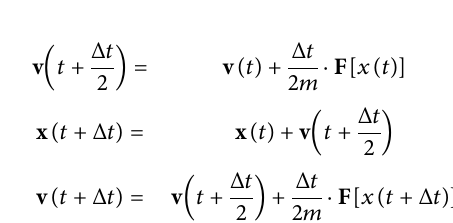
FIGURE 4 | Data fl ow and online learning implementations. Different colors of boxes in the data sequence plots denote online sampling windows with the total length W mixed by distribution P ( t ) , in which solid-line box represents hot data with length w . The green squares inside the sampling window represent sample interval with a length N s . All of the sampling windows will move forward with stride Δ l